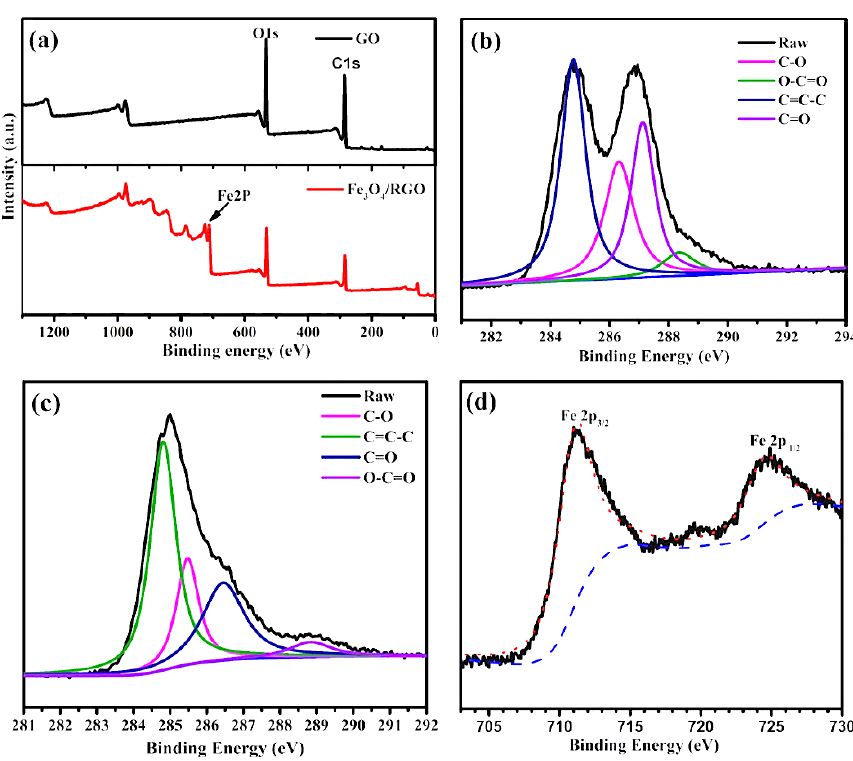
Figure 3. ( a ) XPS survey spectra of GO and Fe 3 O 4 /RGO, ( b ) C 1 s region of GO, ( c ) C 1 s region of Fe 3 O 4 /RGO, and ( d ) Fe 2 p region of Fe 3 O 4 /RGO.